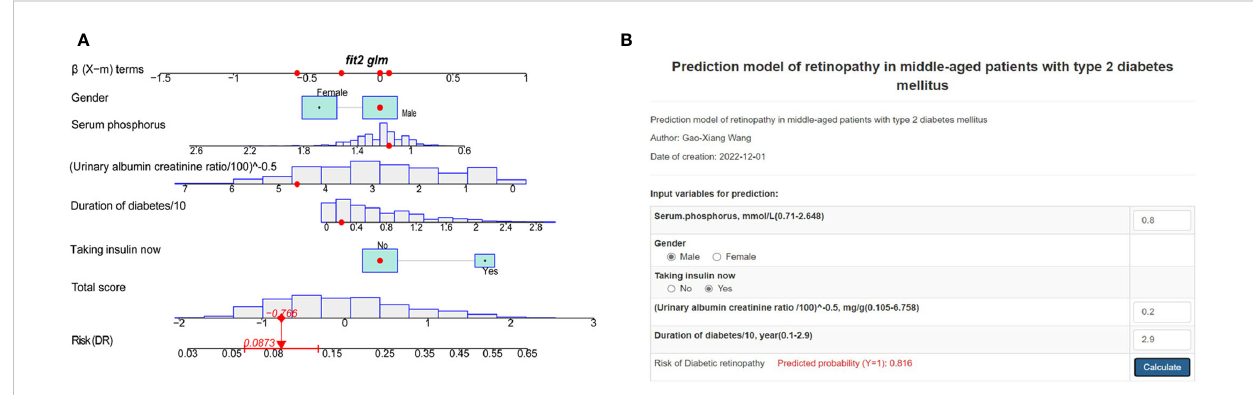
FIGURE 4 Risk nomogram development. (A) An example of the dynamic nomogram. (B) An example of the online dynamic nomogram